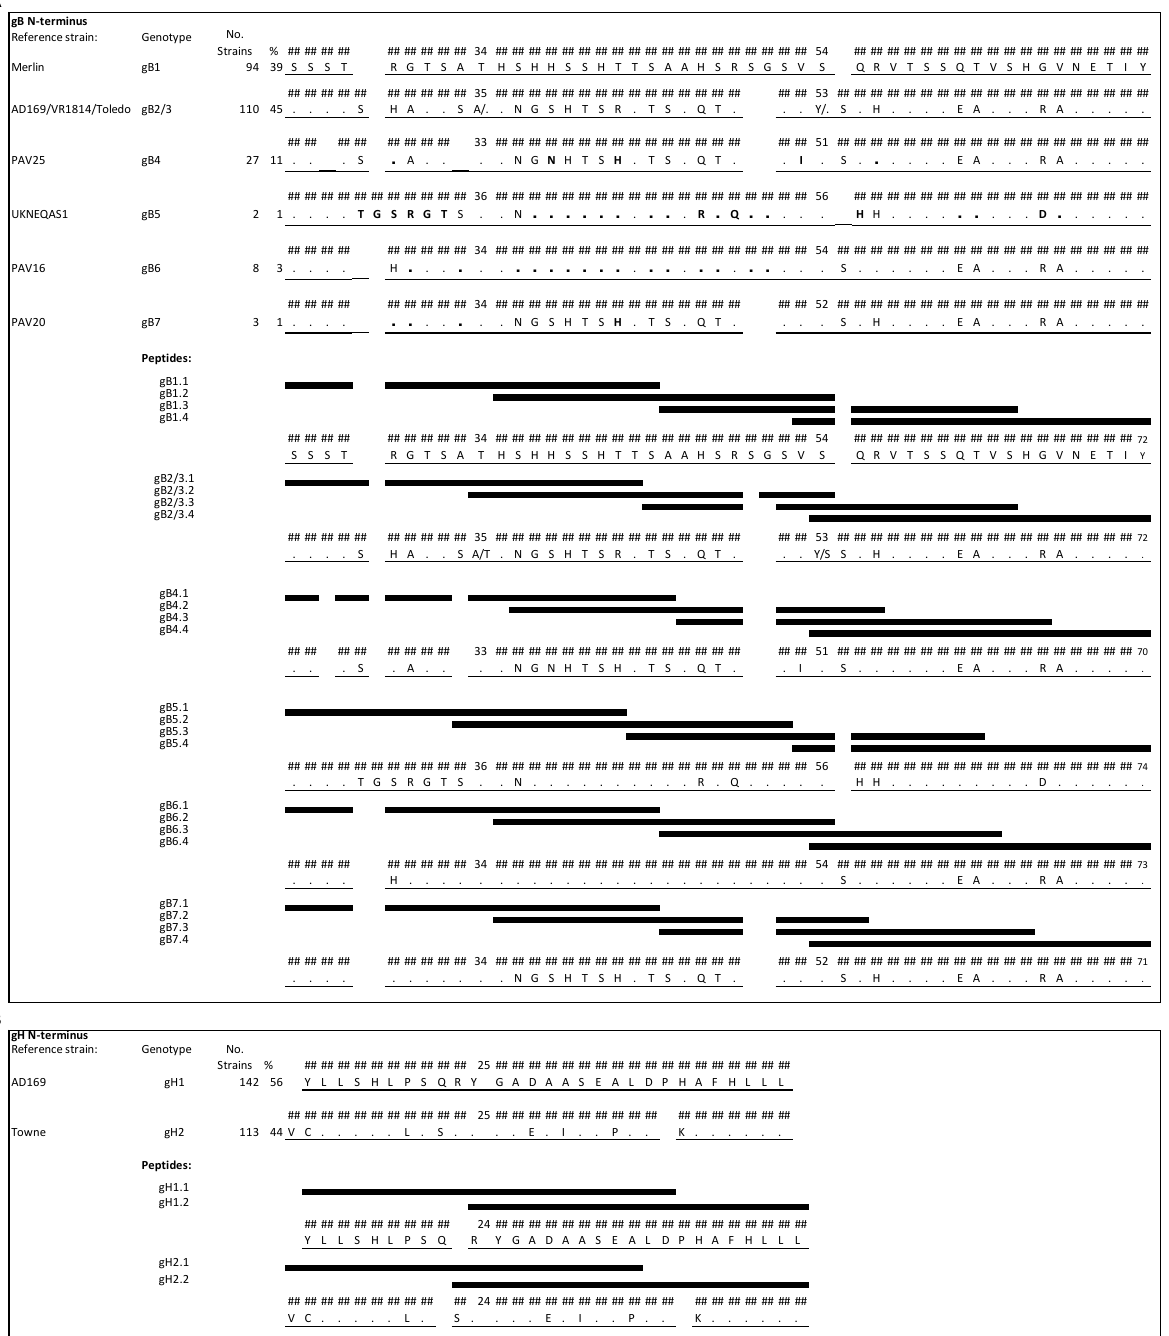
Figure 1. N-terminal regions of gB and gH genotypes aligned to genotype-specific peptides (black bars). Numbering is relative to the primary translation product, with the signal peptide present. ( A ) N-terminal region of gB showing the greatest diversity among the seven genotypes (gB1-7). The amino acid sequences of HCMV strains representing the genotypes are shown, using the strain Merlin sequence (gB1) as a reference. Amino acid residues (aa) that differ from those in the reference are reported, and residues that are identical in the reference are indicated by dots. Positions in gB4-7 that differ from those in gB2/3 are represented in bold. Each peptide differs in at least one residue except gB4.4 and gB6.4, which are identical, as well as one of the two peptides contained in the mixture of gB2/3.4 and peptide gB7.4. ( B ) N-terminal region of gH that distinguishes the two genotypes (gH1-2). Each peptide was biotinylated at the N-terminus, a flexible hydrophilic linker (trioxatridecan-succinamic acid) was inserted between the biotin moiety and the peptide, and a glycine amide was added at